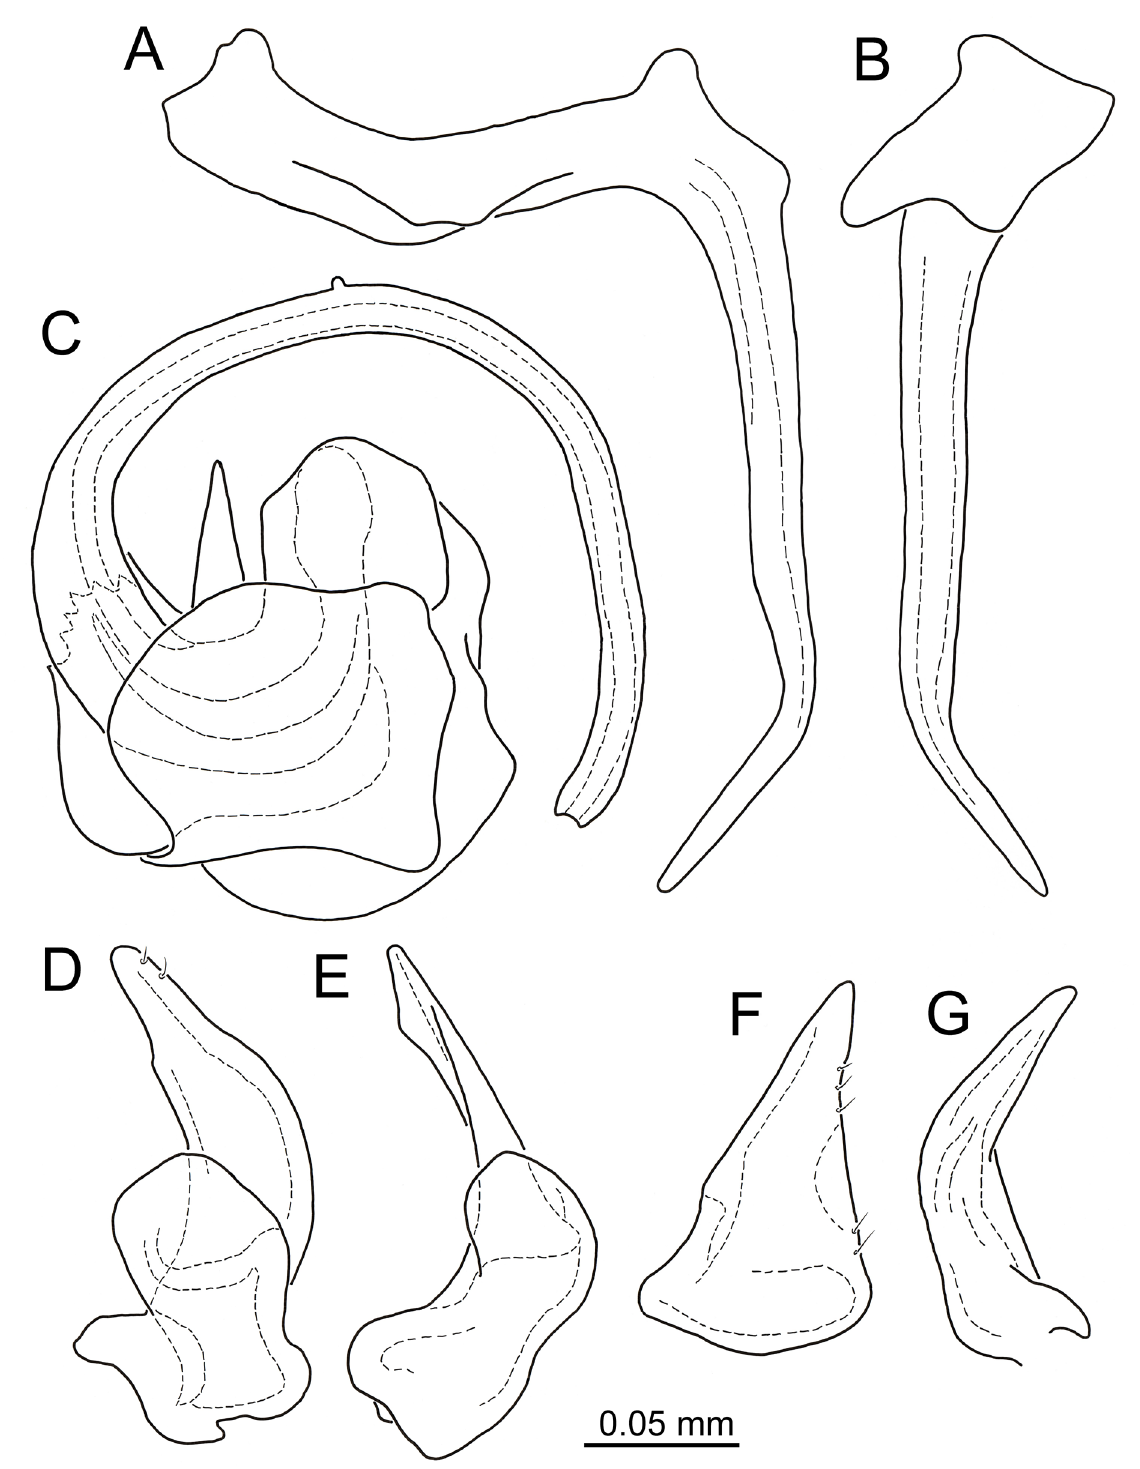
Fig. 2. Kokeshia acutiformis sp. nov., segment VIII and genitalia, paratype, ♂ (SYSBM). A‒B . Left hemitergite VIII. A . Dorsal view. B . Right lateral view. C . Phallus. D‒E . Left paramere, two different aspects. F‒G . Right paramere, two different